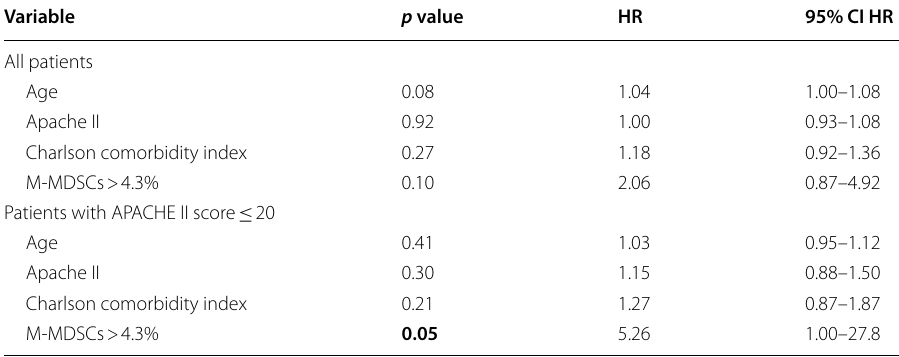
p value < 0.05 is highlighted in bold